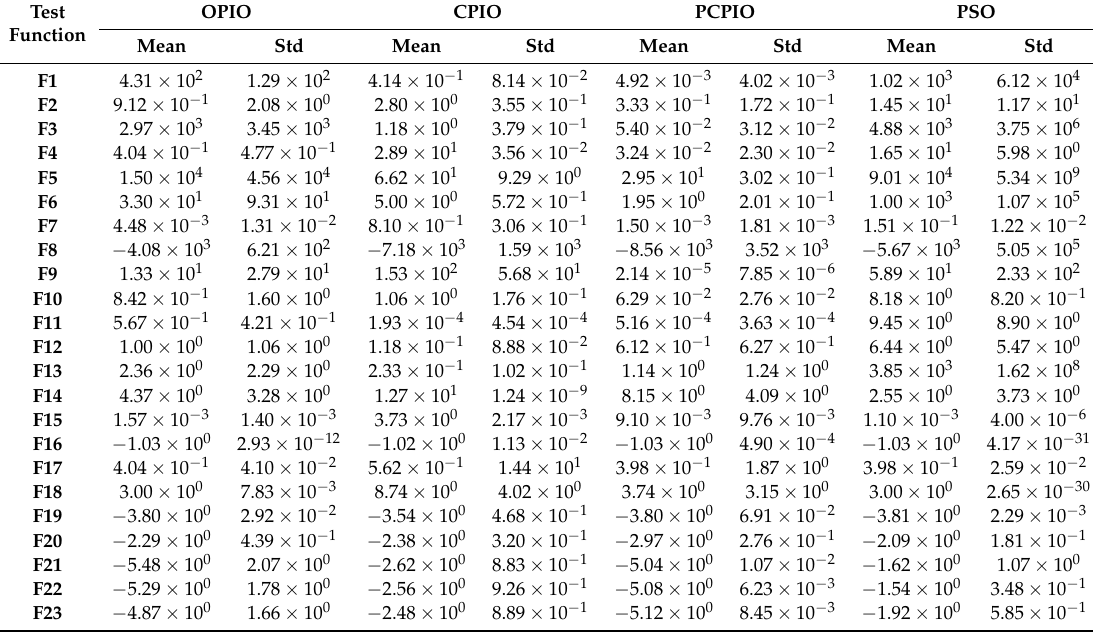
Table 4. Comparison of OPIO, PPIO, PC-PIO, and PSO